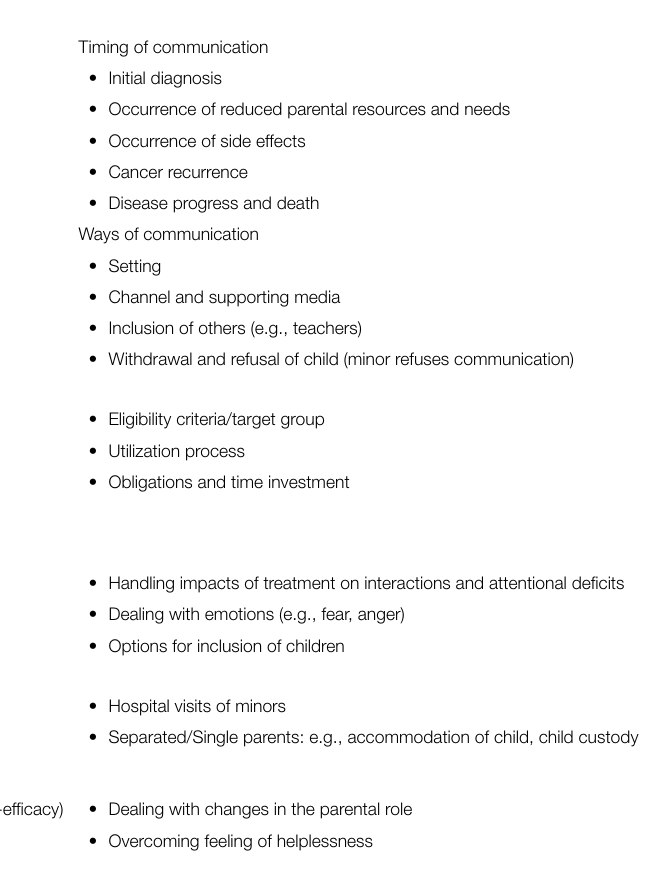
TABLE 2 | Specific information needs of affected parents regarding parental cancer reported by study participants ( n = 5 patients, n = 4 partners, and n = 5 experts). (1) Communication with